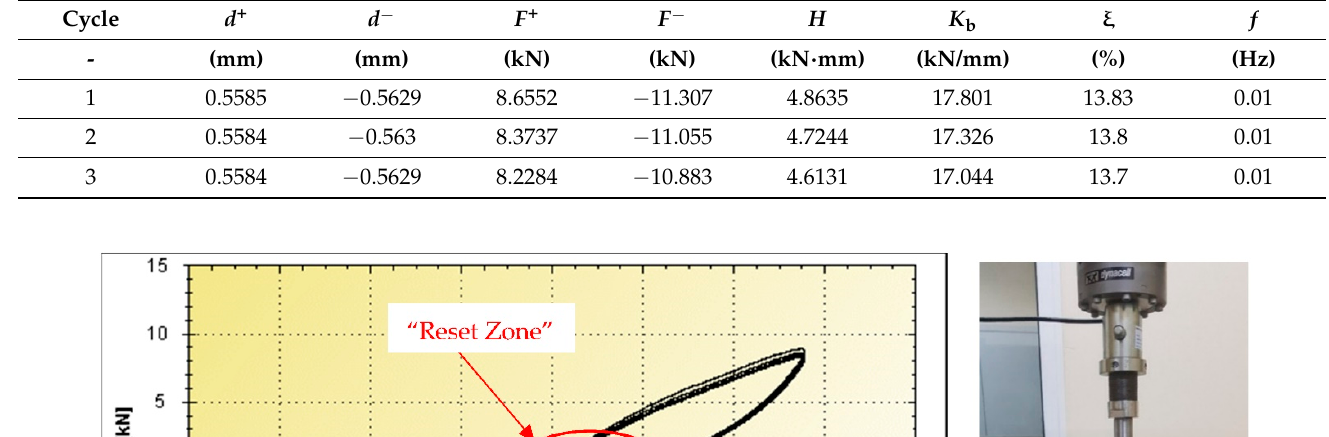
Table 3. Result data for force–displacement under pure compression.